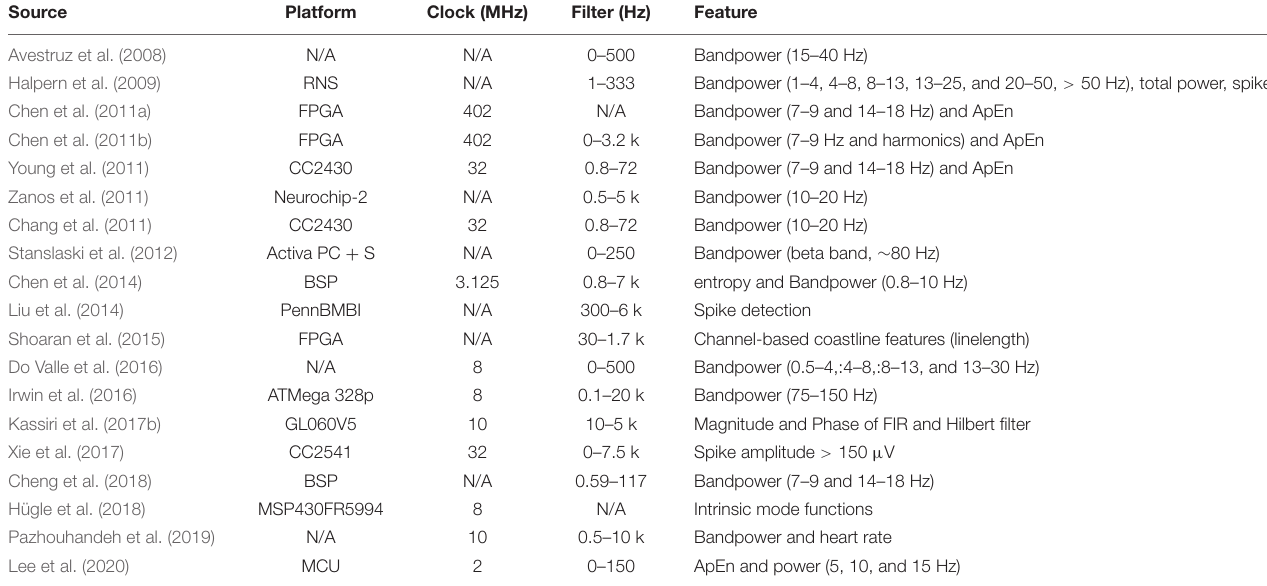
TABLE 6 | The closed-loop stimulation system for